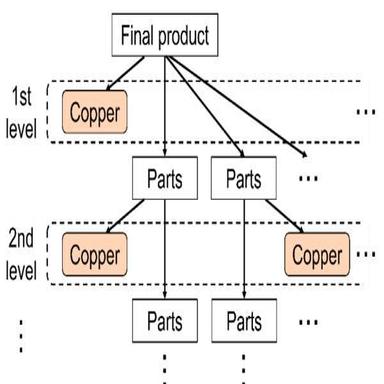
Disassembly tree for calculation of in-product density.